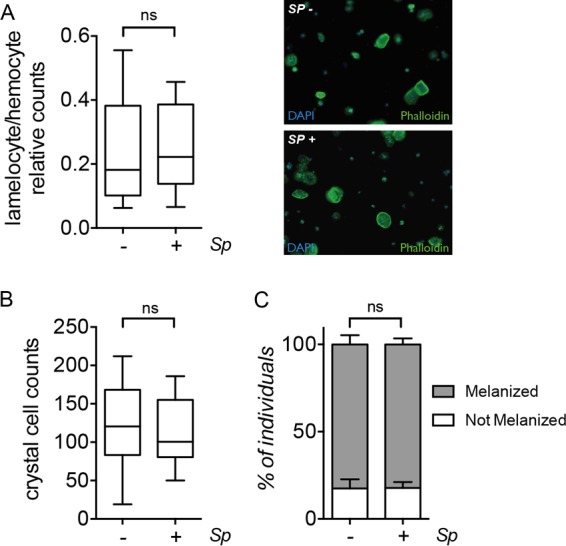
S. poulsonii does not affect the fly immune response. (A) Left, ratios of lamellocytes over total number of hemocytes (plasmatocytes and lamellocytes) in D. melanogaster flies harboring (+) or not harboring (−) S. poulsonii (Sp); right, hemocyte preparation stained with phalloidin to reveal cell shape. Nuclei of hemocytes are stained with 4[prime],6-diamidino-2-phenylindole (DAPI). Lamellocytes are identified by their large size and flat shape (white arrows). ns, P = 0.76; t = 0.3053; df = 33. (B) Crystal cell counts in whole larvae after heat treatment. ns, P = 0.60; t = 0.5260; df = 38. (C) Percentages of melanized wasp eggs or larvae. Data shown are from an experiment representative of three independent experiments. ns, P = 0.6110; t = 5363; df = 6. Statistical significance was calculated using the unpaired Student’s t test.